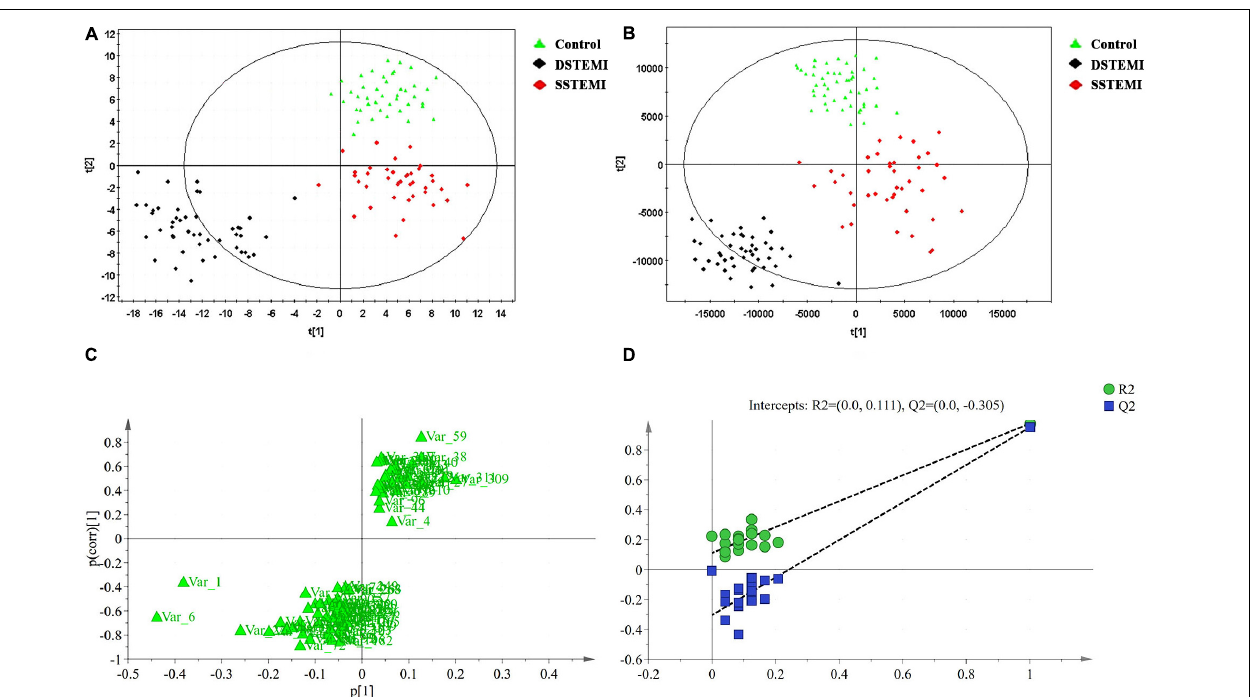
FIGURE 1 | Discriminant analyses and validation. The principal component analysis (PCA) model (A) is established with seven principal components for SSTEMI, DSTEMI, and control group. The orthogonal partial least squares discriminant analysis (OPLS-DA) model is used to magnify the nuances (B) . S-plot (C) and the supervised model (D) are validated. DSTEMI, death group of ST-segment elevation myocardial infarction; SSTEMI, survival group of ST-segment elevation myocardial